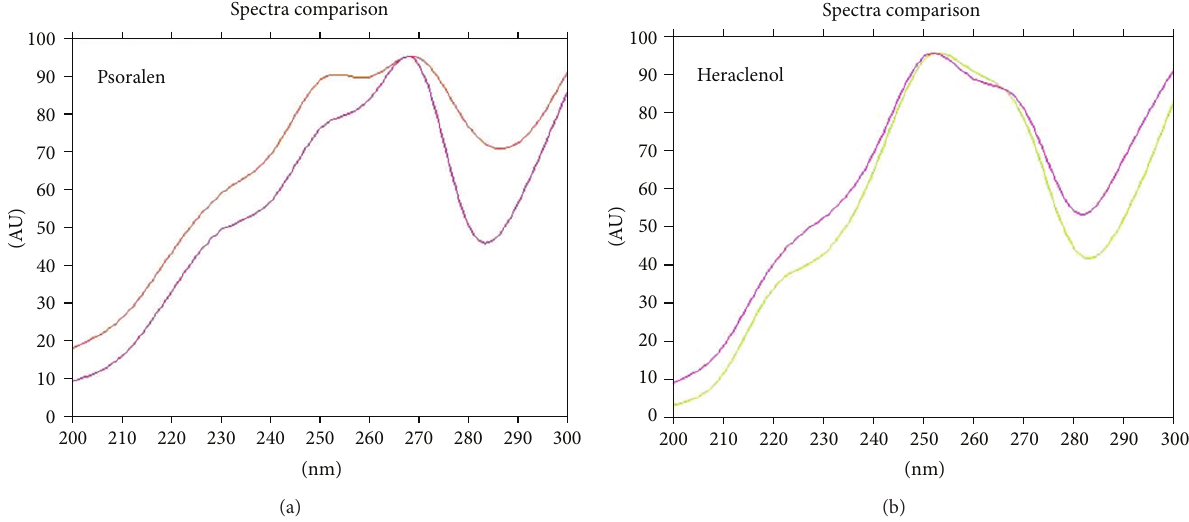
Figure 2: Spectrum of psoralen (1) and heraclenol (2) along with methanolic extract of H. candicans fruits.